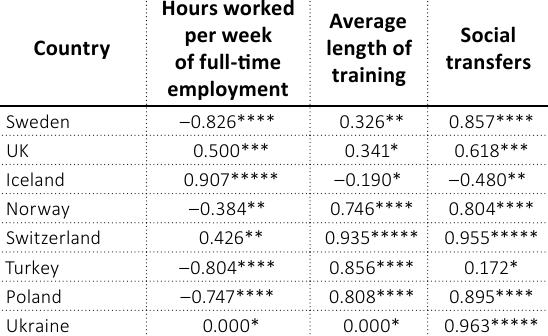
Table 4. Relationship between average income and the factors affecting it in individual EU member states and